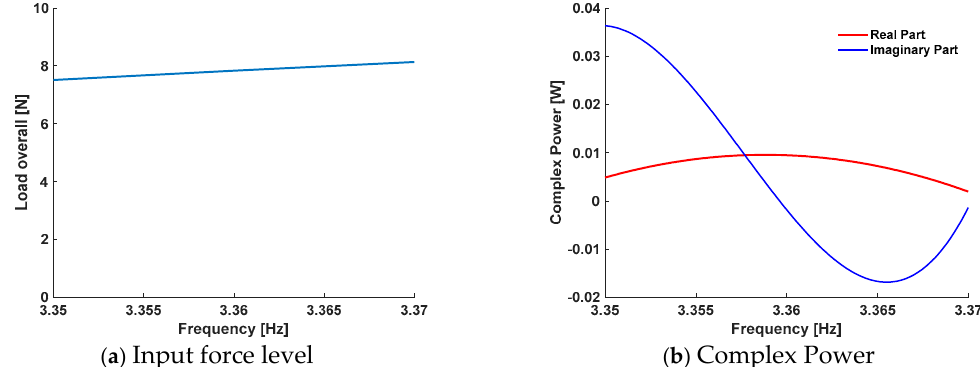
Figure 24. Tab normal mode in power on configuration.